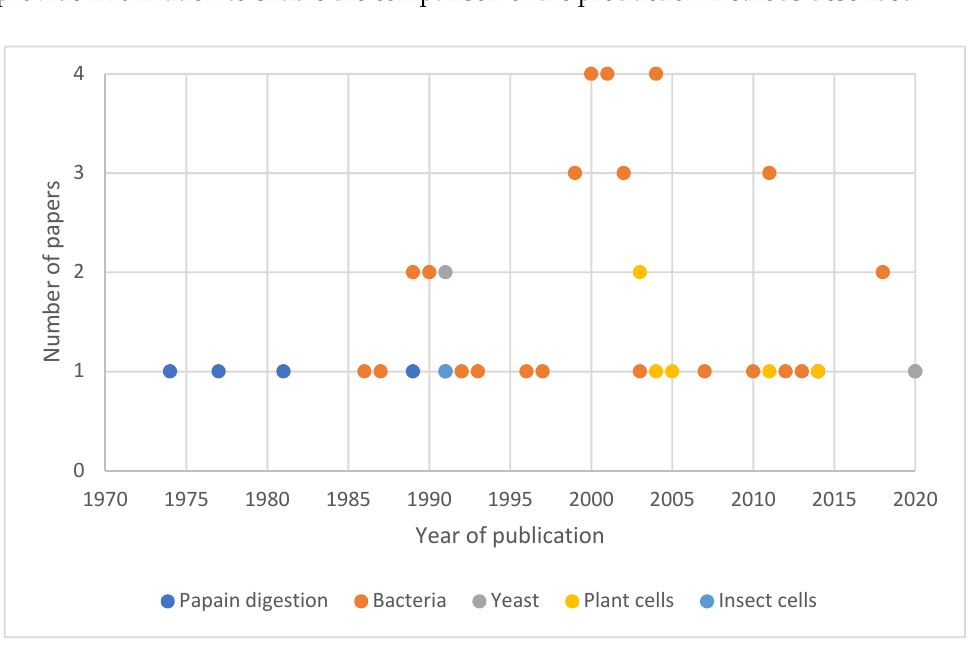
Figure 4. Diversity of TTFC production over the years. Before 1984, only papain was used to obtain TTFC (in blue); then recombinant systems were developed, the most widely used being bacteria (in orange). Some studies were also conducted on TTFC production in yeast (in grey), plant cells (in yellow) and insect cells (in light blue). The number of papers published using these methods are provided on the Y -axis.